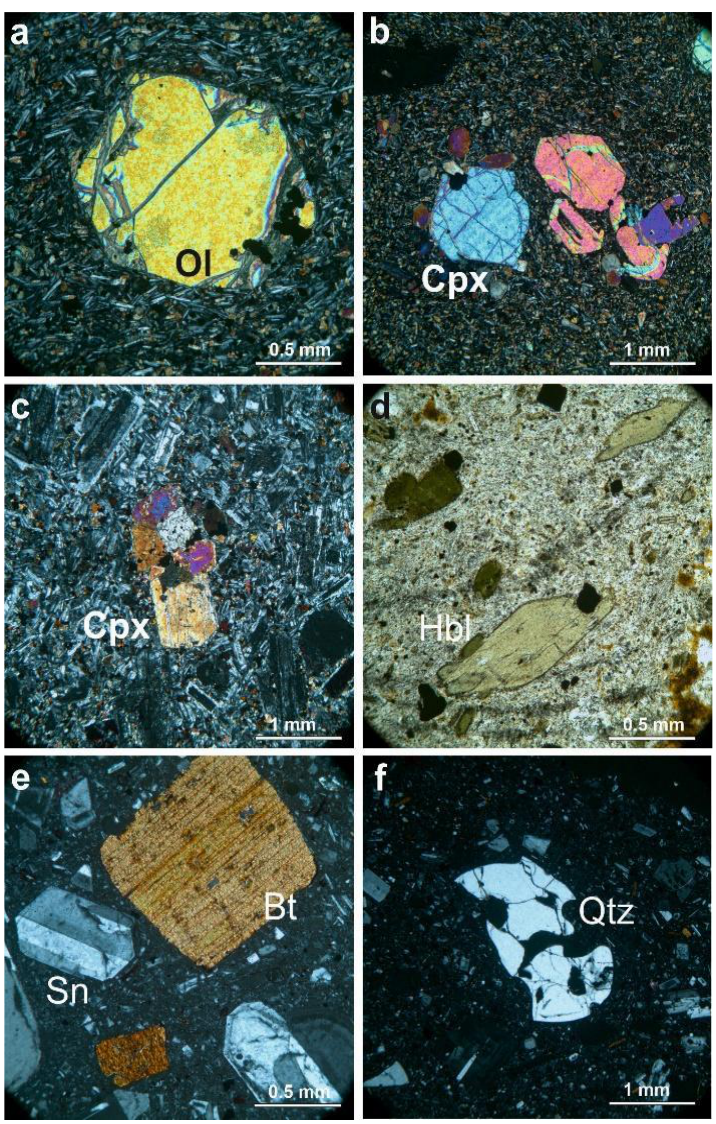
Figure 4. ( a ) Iddingisitization of the partly fresh olivine in the basalt. ( b ) Clinopyroxene phenocrysts in the V1 unit. ( c ) Mineral cloths in the andesitic V2 units. ( d ) Apparent pleochroism of the amphibole phenocrysts in the V2 unit. ( e ) General view of the phenocryst-rich V3 unit. ( f ) Resorbed quartz phenocrysts embedded in the V3 unit. Ol: olivine, Cpx: clinopyroxene, Hbl: hornblende, Sn: sanidine, Bt: biotite, Qtz: quartz.